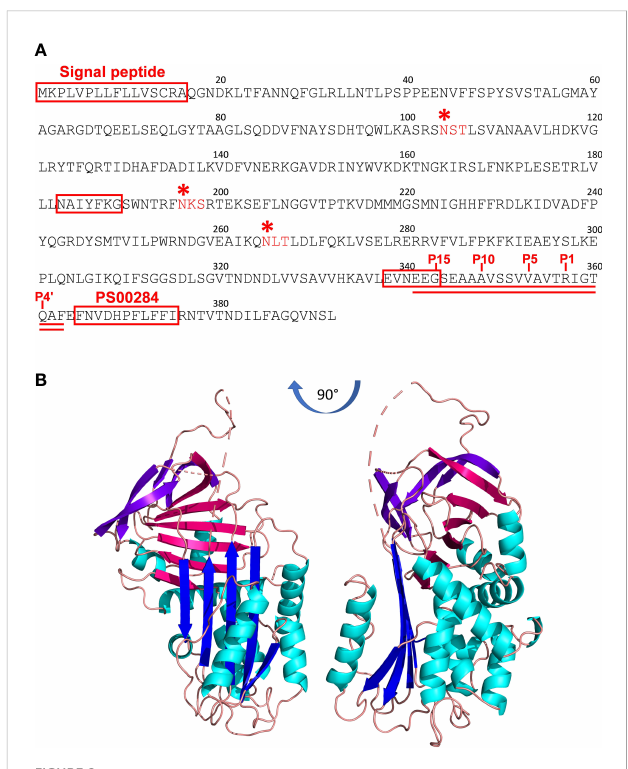
FIGURE 2 The primary and tertiary structure of Iripin-1. (A) The amino acid sequence of Iripin-1. The signal peptide at the N-terminus of the sequence, serpin signature motif PS00284, and serpin consensus amino acid motifs NAIYFKG and EVNEEG are boxed in red. Three predicted N-linked glycosylation sites are marked with red asterisks. The RCL is double underlined. The amino acid residues in the RCL region are numbered based on the standard nomenclature developed by Schechter and Berger (35). According to this nomenclature, the residues on the N-terminal side of the scissile (P1 – P1 ’ ) bond are not primed and those on the C-terminal side are primed. (B) Cartoon representation of the tertiary structure of native Iripin-1. The Iripin-1 structure consists of ten a -helices (cyan) and three b -sheets, of which b -sheet A is blue, b -sheet B is magenta, and b -sheet C is purple. Loops are colored salmon. The loop regions of the Iripin-1 structure with missing amino acid residues because of a poor electron density map are depicted as dashes. The RCL can be seen at the top of the molecule where it acts as a bait for target